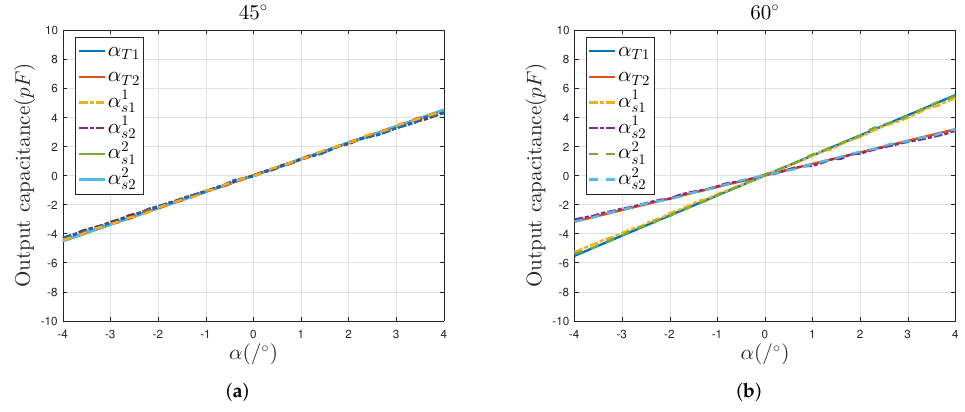
Figure 4. Comparison of theoretical and simulation values of the output capacitance: ( a ) the output capacitance in the direction of 45 ◦ , ( b ) the output capacitance in the direction of 60 ◦